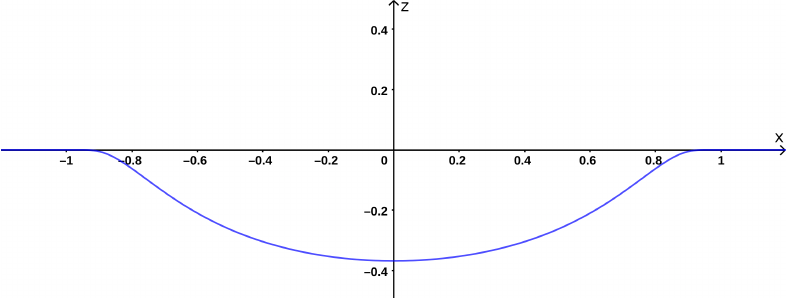
Figure 8. Section of the reference dent function. Maximum depth is 0.368 and just 0.005 at x = 0.9.